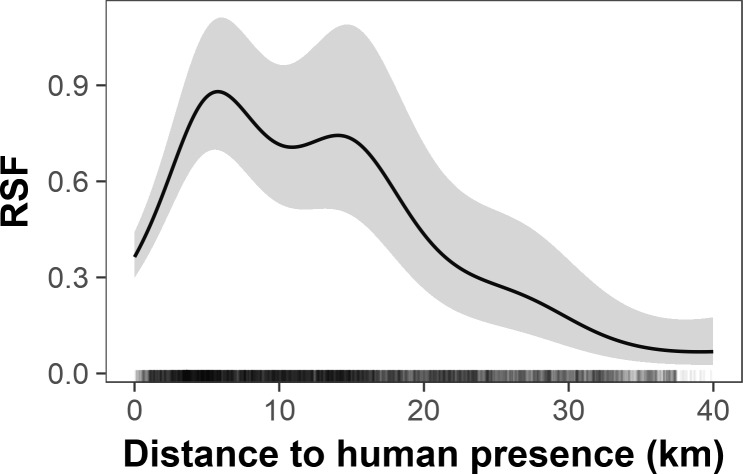
Predicted resource selection function (RSF) for elephants satellite-tracked in southeast Angola, 2010–2016.Shading indicates ± 1 SE. Tick marks on x-axis indicate density of data points from tracked elephants.